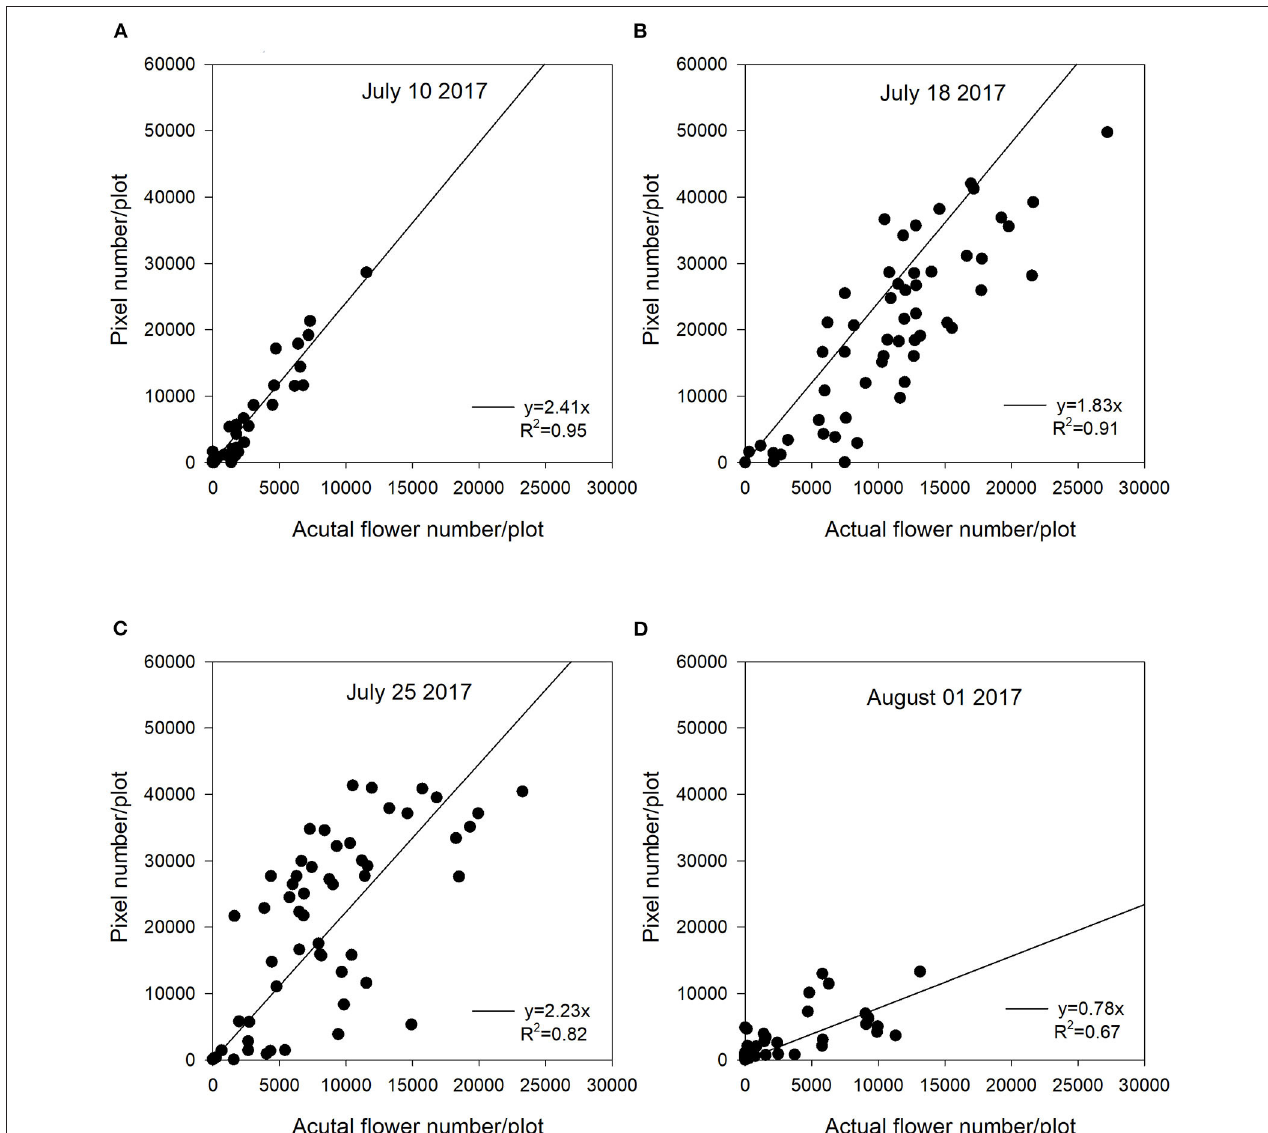
FIGURE 4 | The relationship between actual flower numbers per plot and pixel numbers extracted from aerial images during the flowering stage at Saskatoon, SK, Canada in 2017. Actual flower numbers per plot were manually measured. Pixel number per plot was detected by the thresholding method. (A) Regression equation for July 10, 2017: y = 2.41x, R 2 = 0.95. (B) Regression equation for July 18, 2017: y = 1.83x, R 2 = 0.91. (C) Regression equation for July 25, 2017: y = 2.23x, R 2 = 0.82. (D) Regression equation for August 01, 2017: y = 0.78x, R 2 =